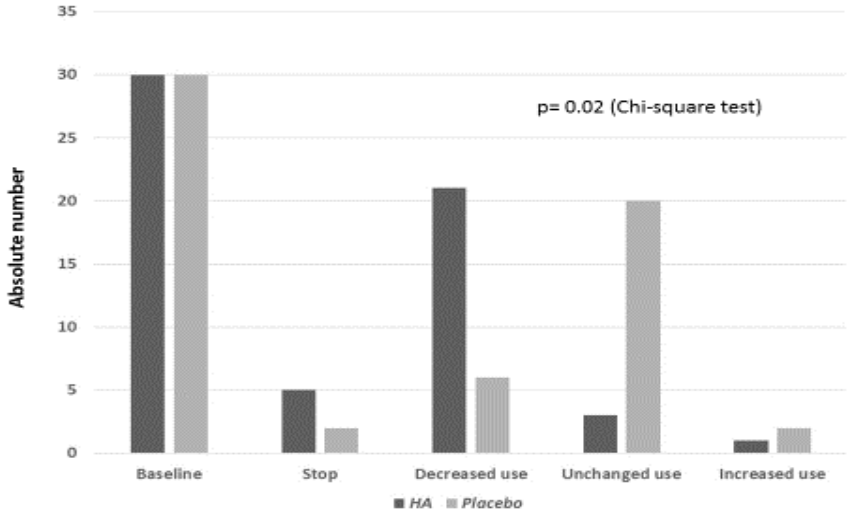
Figure 1. Modification of anti-pain and/or non-steroidal antinflammatory drugs (NSAIDs) weekly use pattern during the trial in the hyaluronic acid (HA) and placebo-treated subjects.